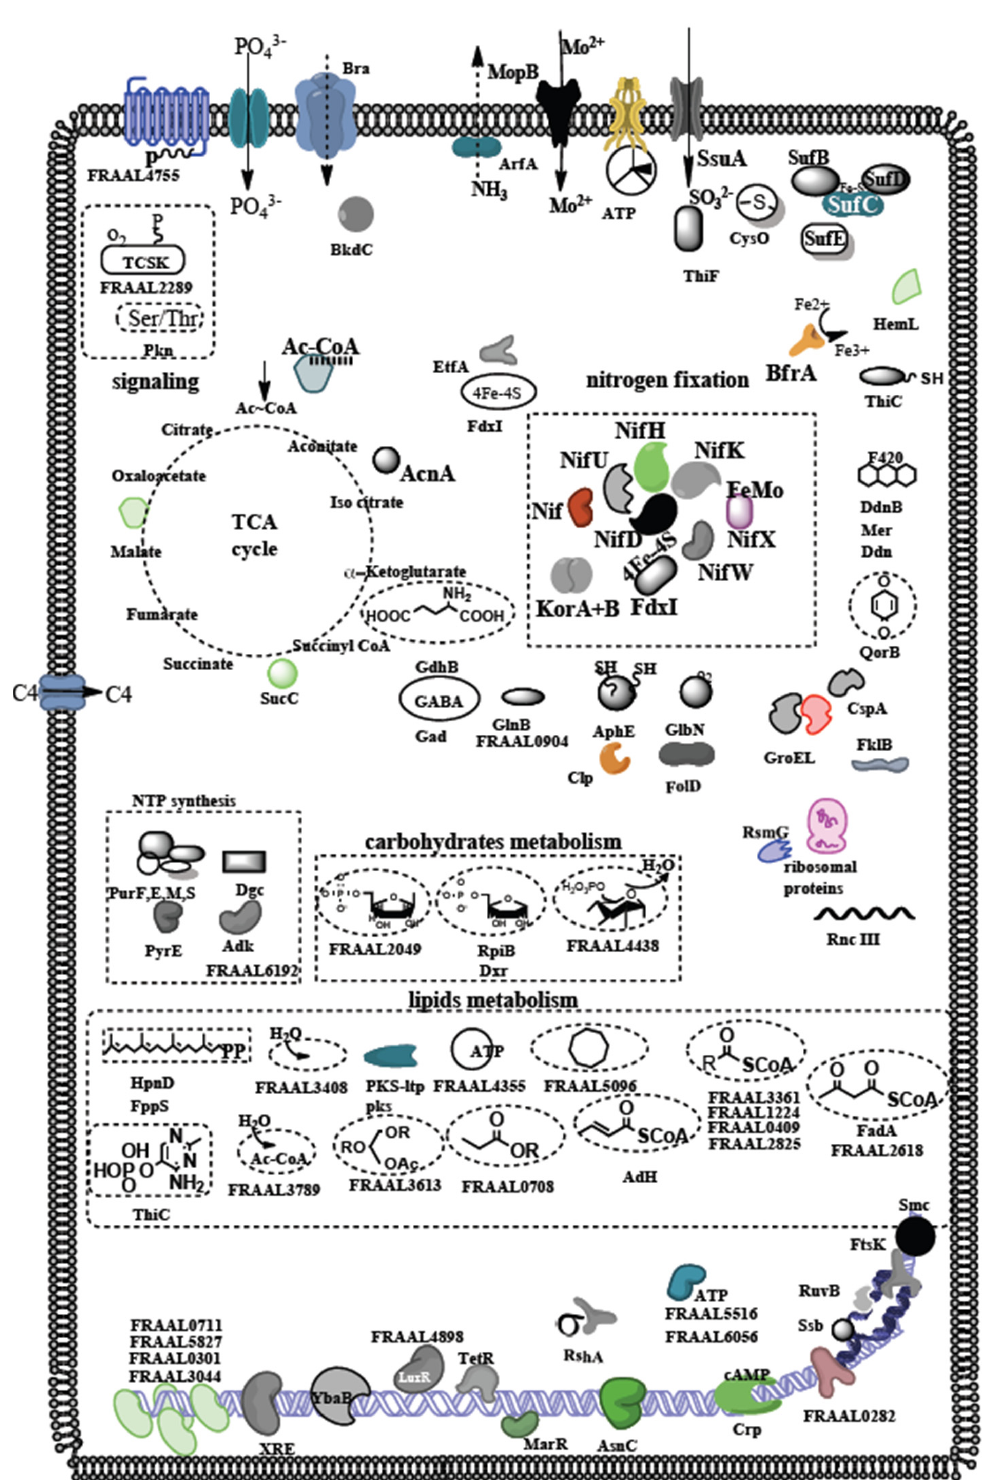
Figure 3. Schematics of a Frankia cell in its symbiotic host cell showing the likely function and localization of the 100 most abundant proteins related to nitrogen fixation, lipid metabolism, Krebs cycle (TCA), cell signaling, electron transfer, transport of anions and cations, enzymes involved in nucleotides biosynthesis, DNA metabolism and regulation and storage and stress proteins. The identities of the proteins and specific genes are listed in Table 1.